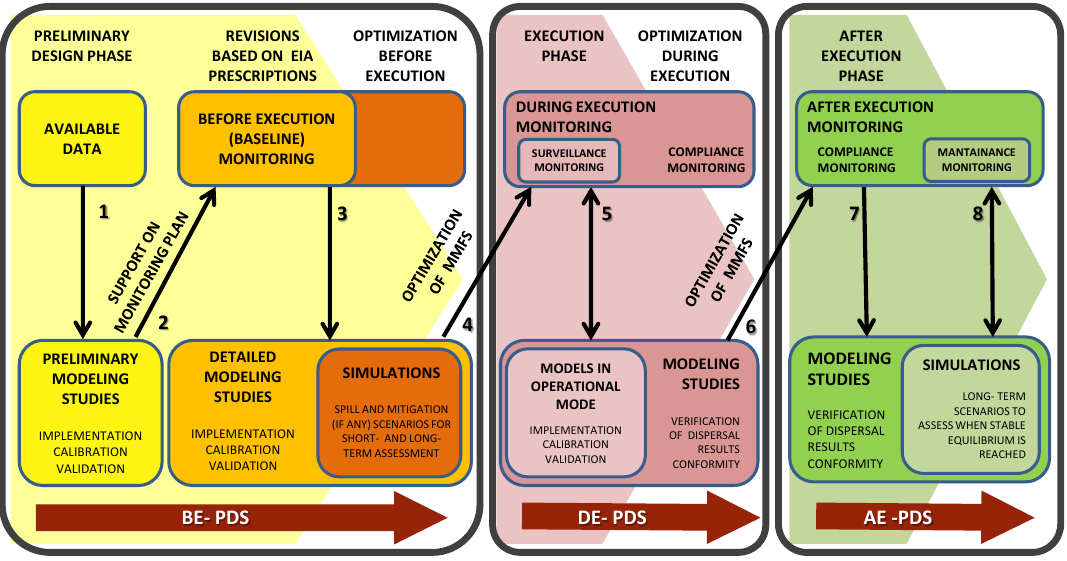
Scheme of the modeling–monitoring feedback system in the different phases of design, execution and management of handling operations. In the scheme, MMFS stands for modeling–monitoring feedback system; BE-BDS, DE-PDS and AE-PDS for project data sheets (PDS) before execution, during execution, and after execution, respectively; EIA for environmental impact